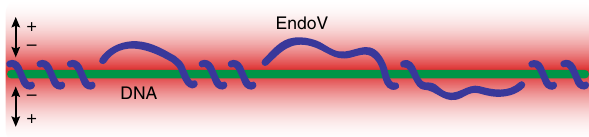
Fig. 4 Model of interspersed helical sliding and hopping on DNA. The protein trajectory (blue trace) is con fi ned within the radial electrostatic fi eld (red to white) surrounding the DNA (green) to achieve rapid reassociation to DNA and ef fi cient target localization during DNA scanning. Number of turns and length of hopping steps are unknown parameters and not to